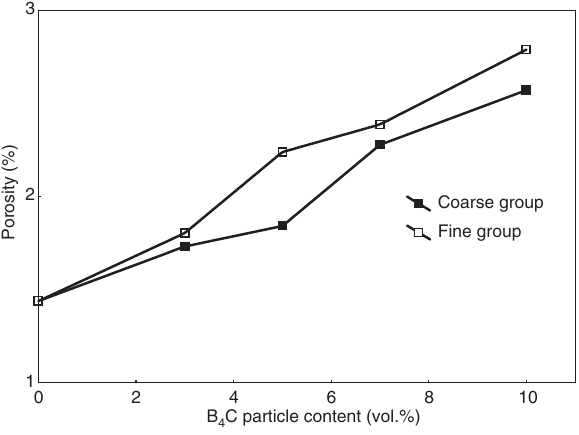
C particle content and size. 4